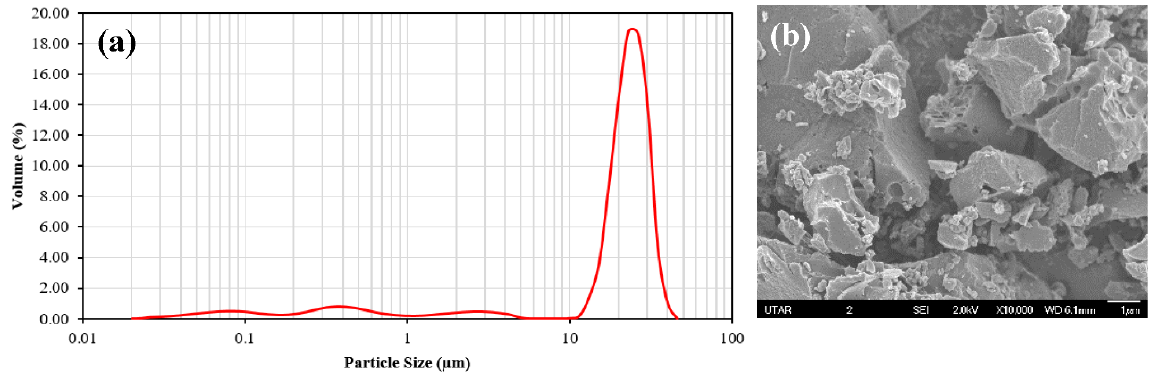
Figure 5. PAC characterization: ( a ) Particle size distribution; ( b ) FESEM image at 10,000× magnification.